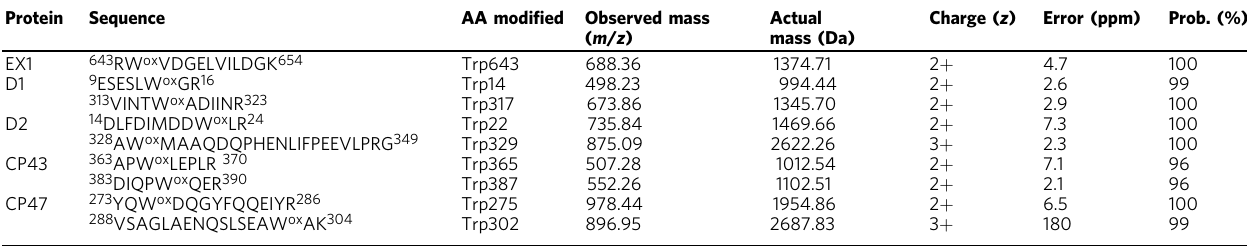
Table 1 Trp oxidation in EX1 and associated PSII proteins Protein